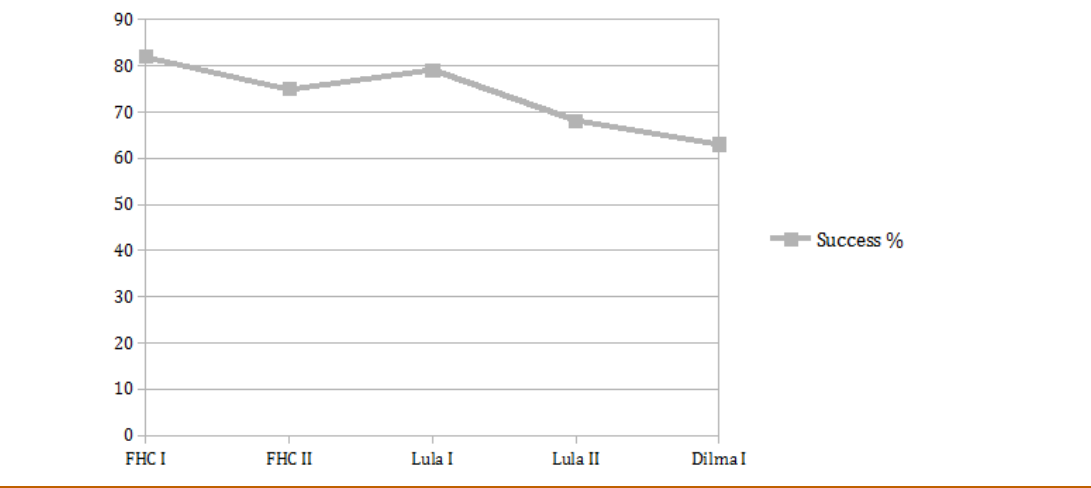
Source: CEBRAP Legislative